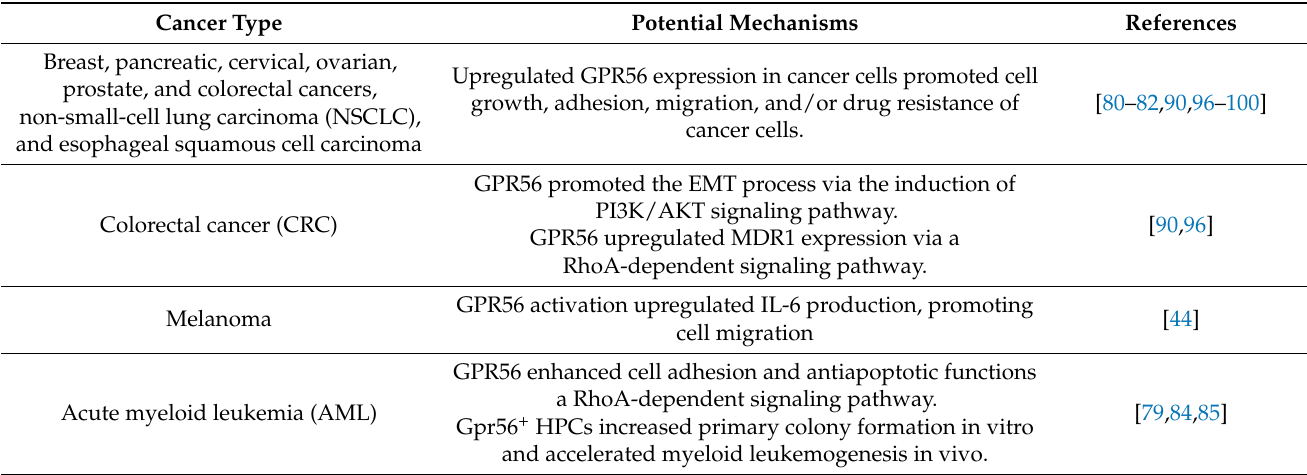
Table 3. The tumor-promoting role of